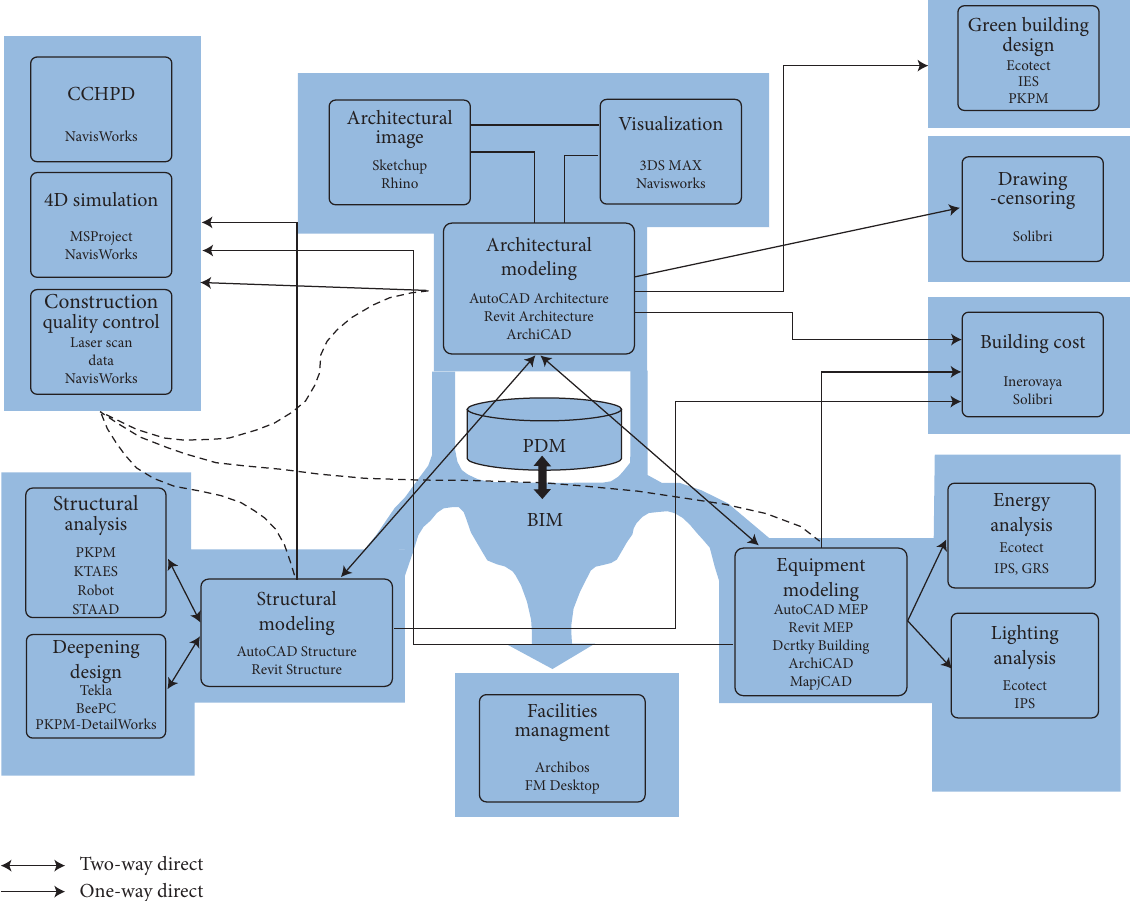
Figure 7: Analysis of greening of container buildings (Zhangzhou Shuangyu Island